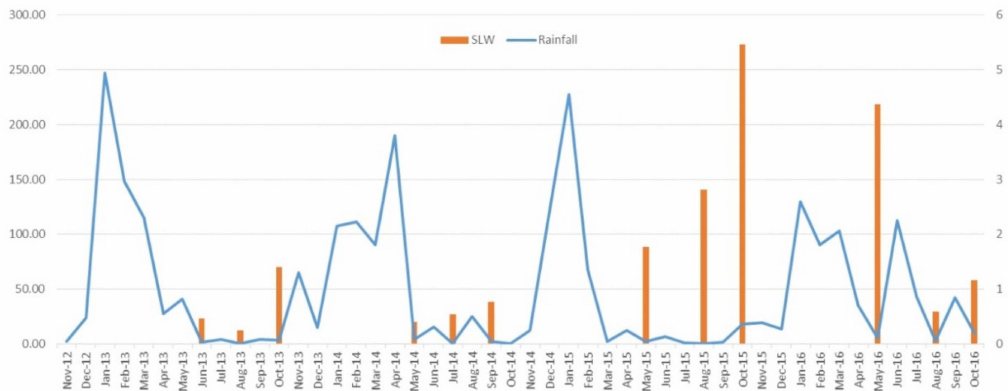
Figure 3. Graph of rainfall and silverleaf whitefly (SLW) populations during the study period. Rainfall is shown in mm on the left y -axis and SLW populations as adults per leaf on the right y -axis. Data is provided as a monthly